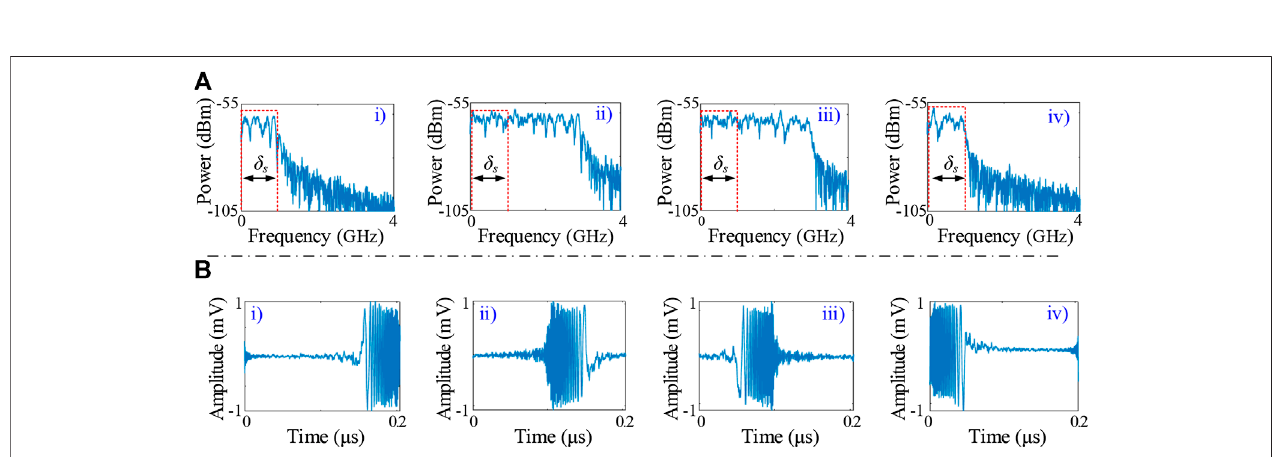
FIGURE 9 | (A) Spectra of the output signals processed by optical hybrids and electrical quadrature hybrids and (B) waveforms of channelized signals after low- pass fi lters, where the 4 GHz linearly-chirped signal has a 28 GHz center frequency.